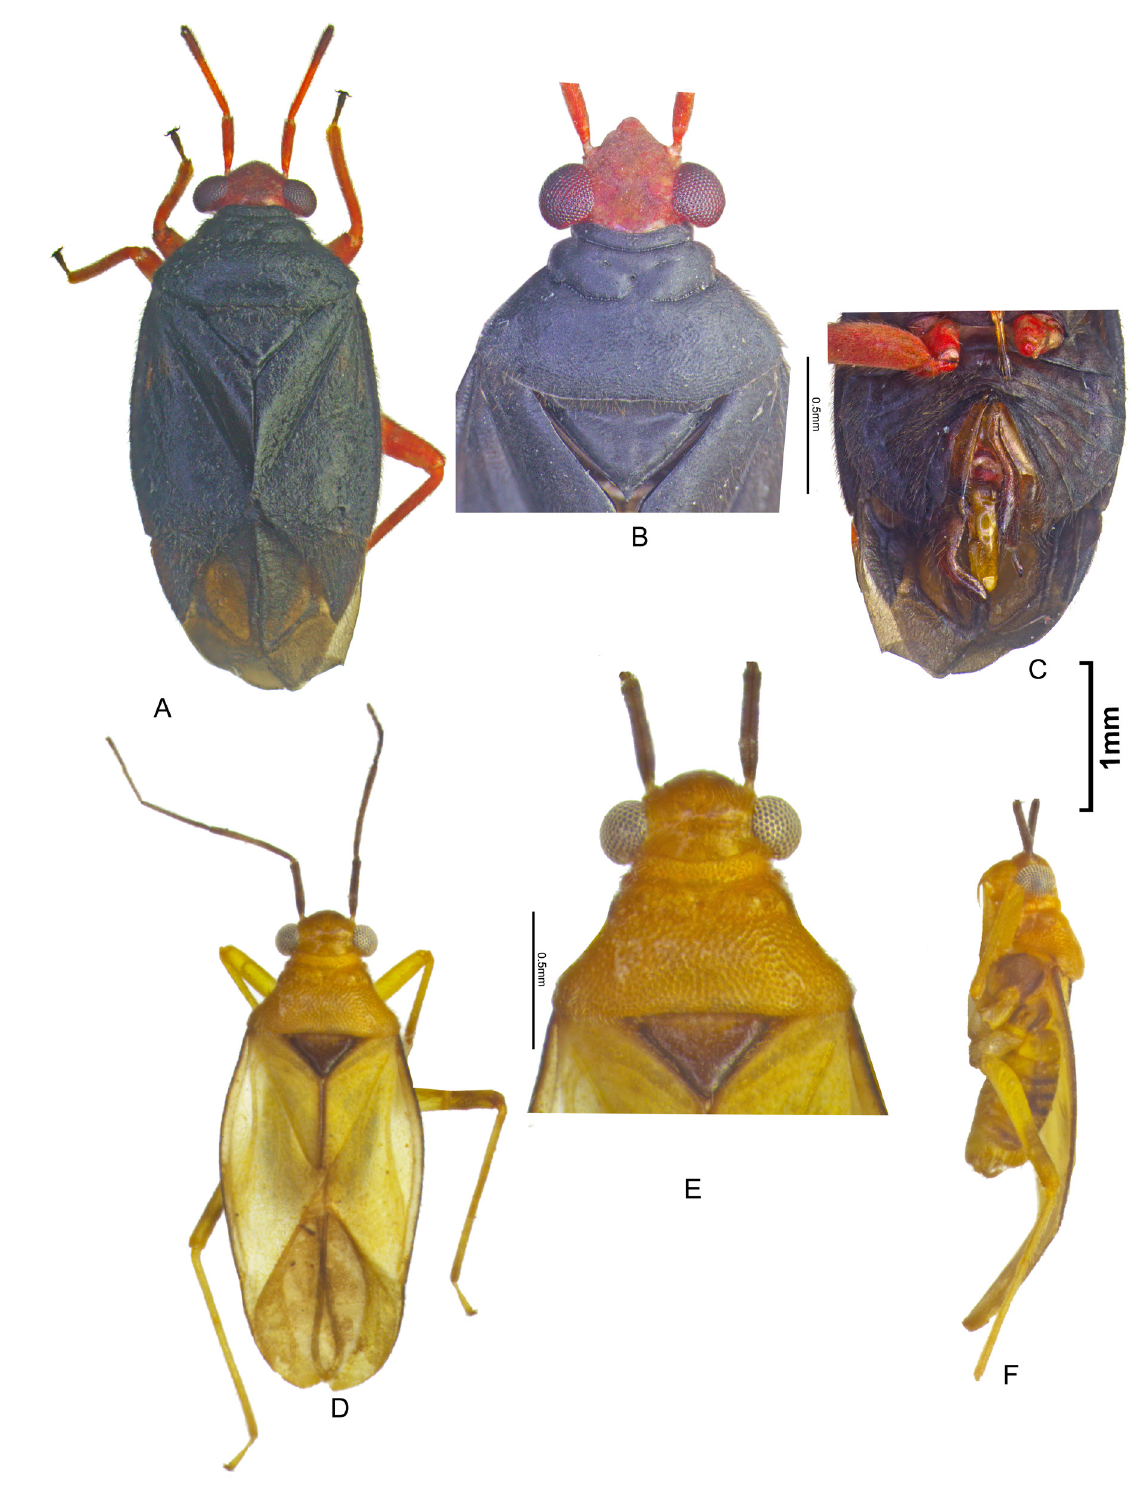
Fig. 3. Habitus of Mertila Distant, 1904 and Namyatovia gen. nov. spp. A–C . Mertila rubrocephala sp. nov., ♂, UASB. A . Dorsal view. B . Head and pronotum in dorsal view. C . Abdomen in ventral